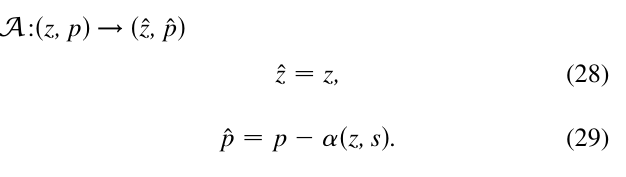
FIG. 2. (Color) Schematic for the evolution of the chirp function in a bunch compressor (top figure) and dynamics in the (cid:2) ^ z; ^ p (cid:4) phase space for a beam with linear chirp (bottom